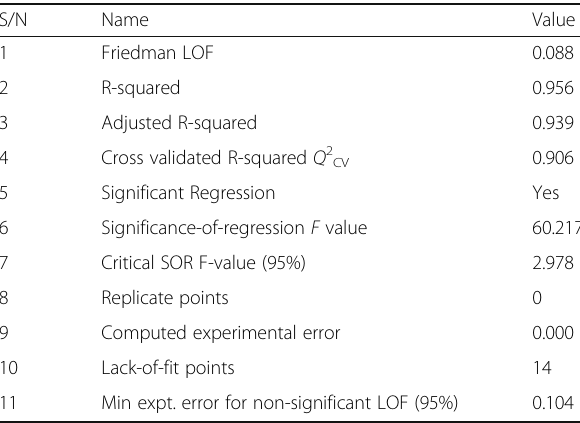
Table 7 Internal validation parameters of the genetic function approximation from the material Studio Program